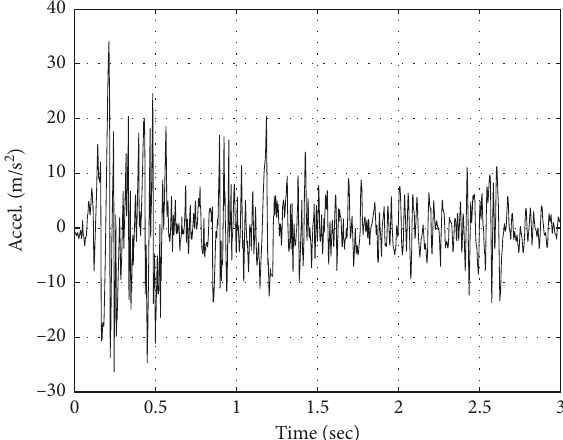
Figure 10: Earthquake motion